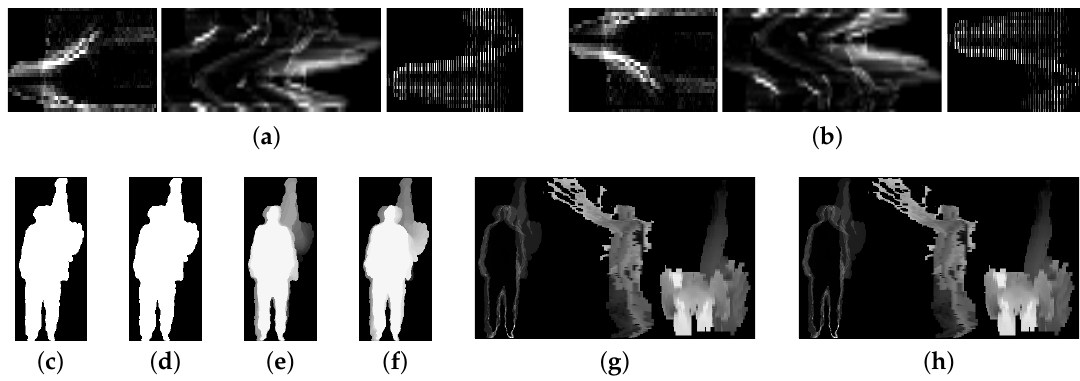
Figure 8. The various feature maps of the positive and reverse order high throw. ( a ) MSTM of positive order high throw; ( b ) MSTM of reverse order high throw; ( c ) MEI of positive order high throw; ( d ) MEI of reverse order high throw; ( e ) MHI of positive order high throw; ( f ) MHI of reverse order high throw; ( g ) DMM of positive order high throw; ( h ) DMM of reverse order high